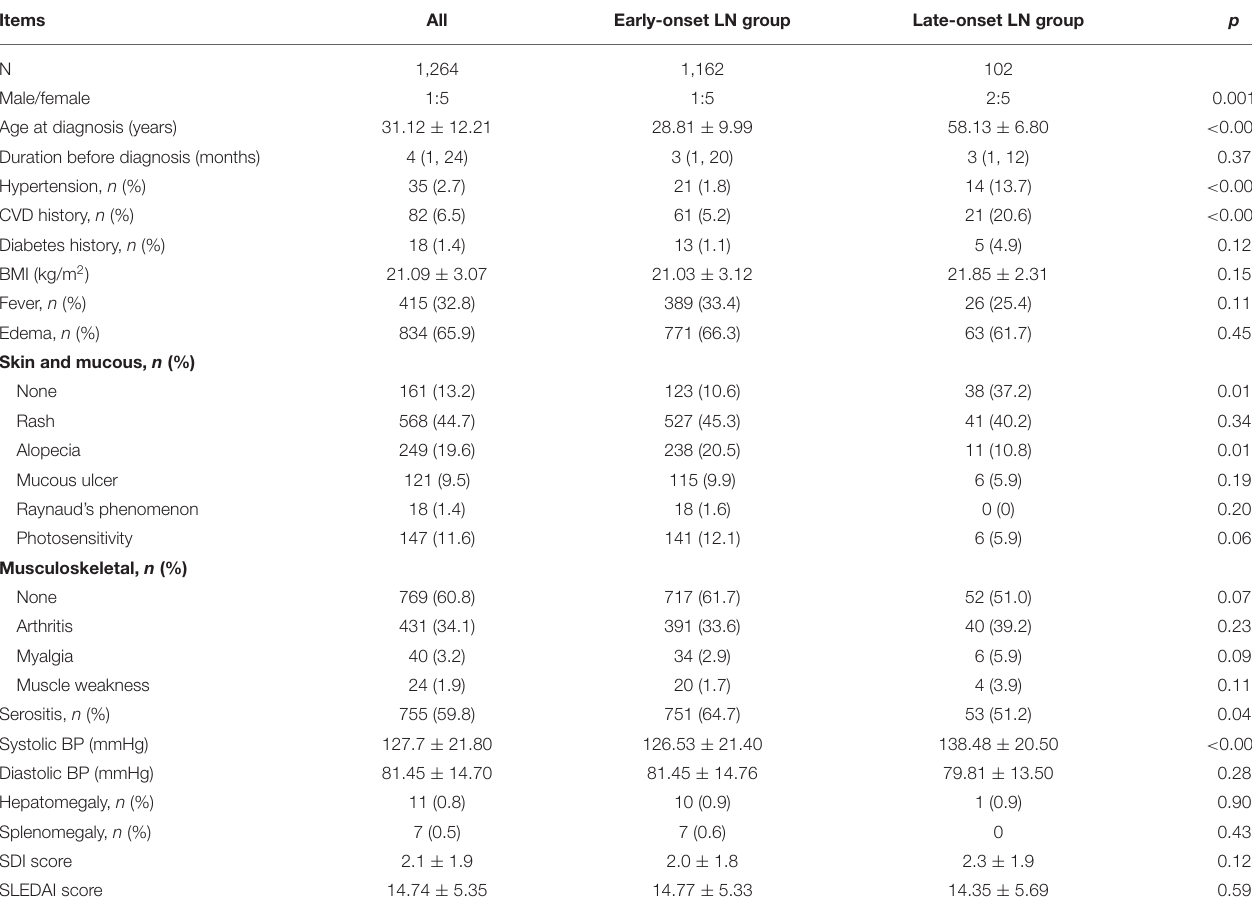
TABLE 1 | Comparisons of baseline clinical manifestations between late- and early-onset LN groups. Items All Early-onset LN